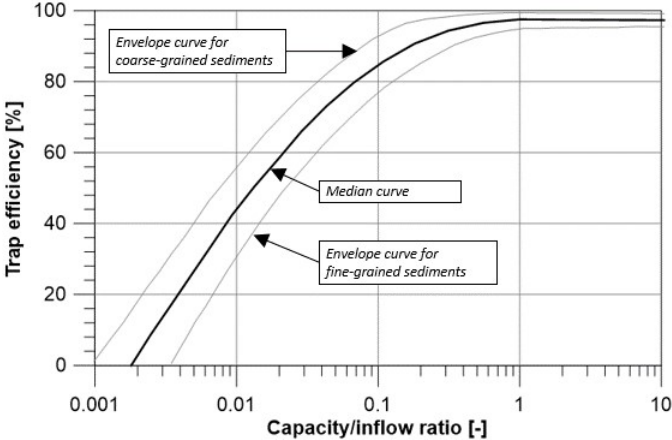
Figure 5. The relationship between a reservoir’s trap efficiency and its capacity to the mean annual inflow runoff ratio as proposed by Brune [21].